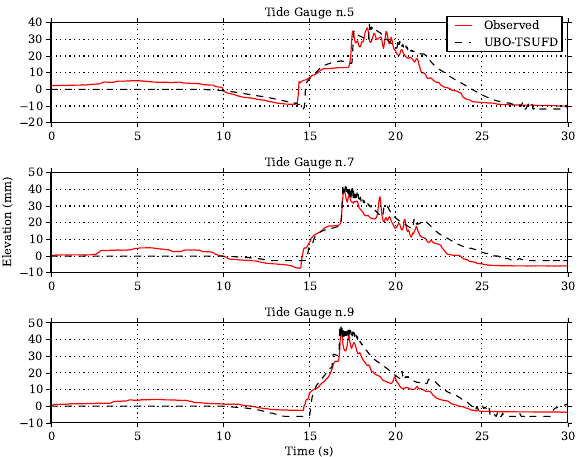
Fig. 18. Benchmark n. 4: comparison of time histories at the bench- mark probes. Experimental records (black dashed line) are quite noisy and deflect from zero before the arrivals of the wave. The wave has a leading depression. The arrival of the positive front is simulated quite well, including the abrupt change of elevation close to the crest. The decreasing part of the record is slightly delayed in the simulations. The comparison is limited to 30s because, be- yond this time, the simulation becomes strongly non-linear (break- ing waves) and NSW cannot reproduce this situation well. More- over, the input forcing function does not consider reflecting waves which start to propagate backward and laterally before the forcing is finished. Hence this effect, leading unavoidably to misleading re- sults, cannot be considered in the simulation.